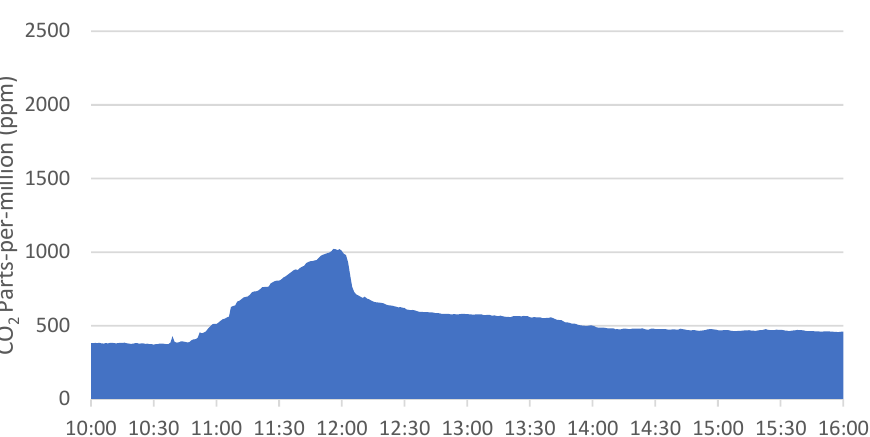
Figure 10. Test A: Full attendance classroom with no air circulation.